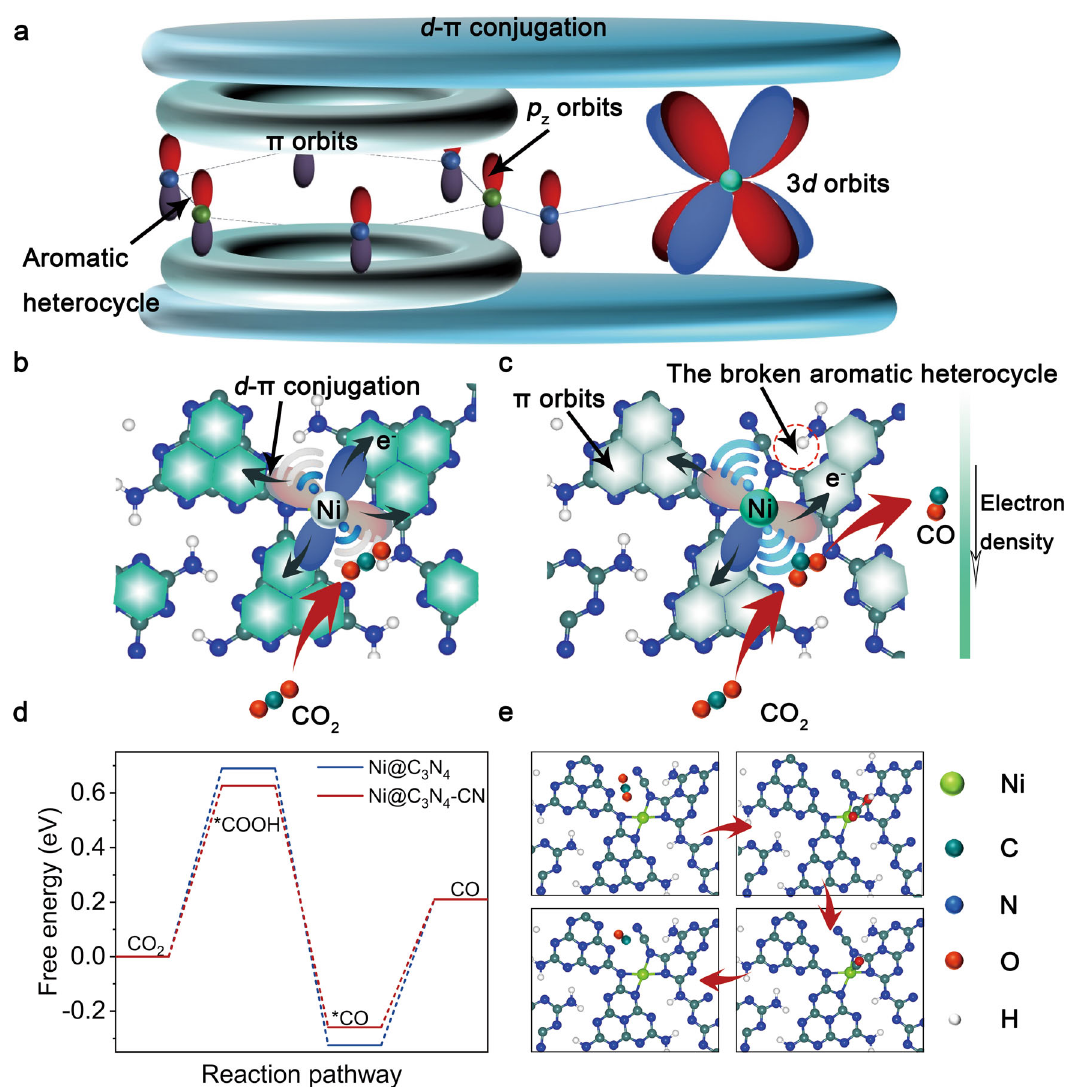
Fig. 1 | Theoretical calculations. a Schematic diagram for d - π conjugation. The effect of d - π conjugation on CO 2 activation, b Ni@C 3 N 4 -CN and c Ni@C 3 N 4 . d Free